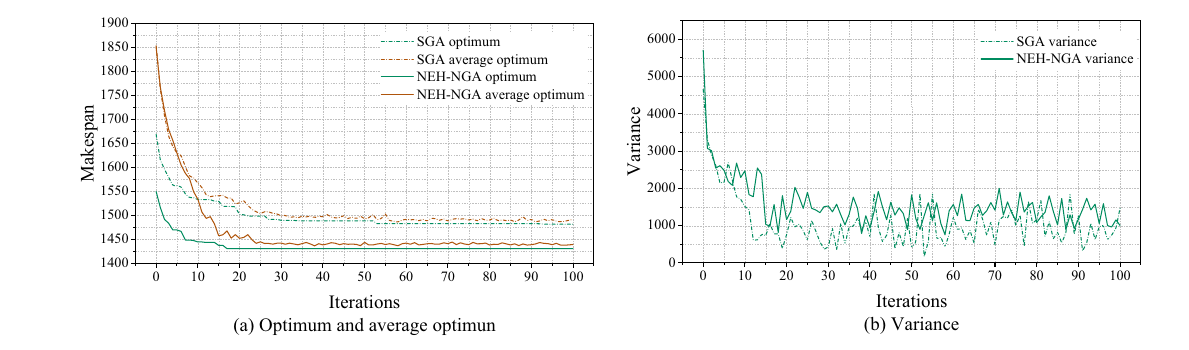
Figure 9. The population evolutionary process of